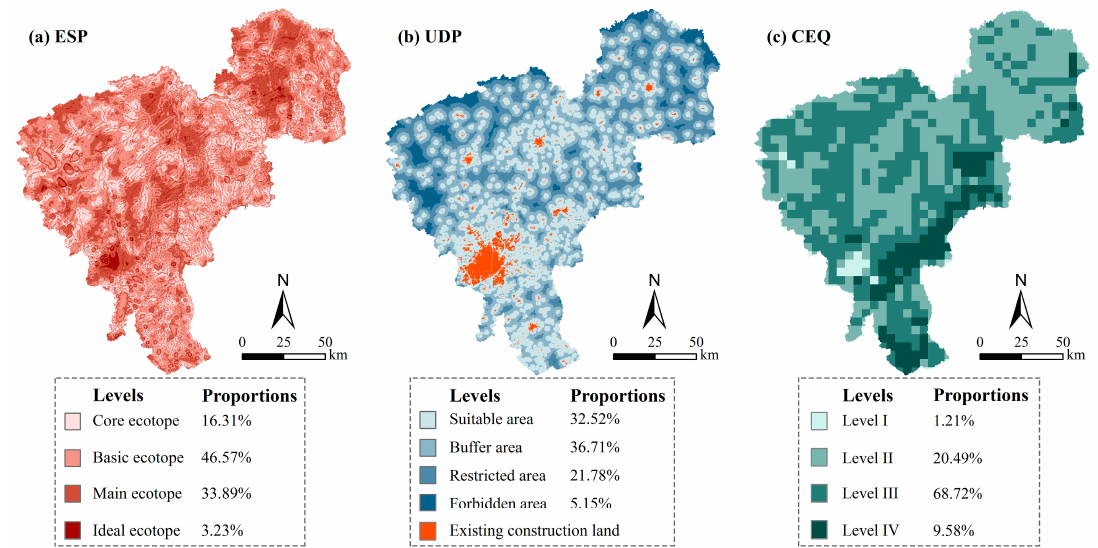
Figure 4. The classification results of ( a ) Ecological security pattern (ESP); ( b ) Urban development pattern (UDP); and ( c ) Cropland ecological quality (CEQ).